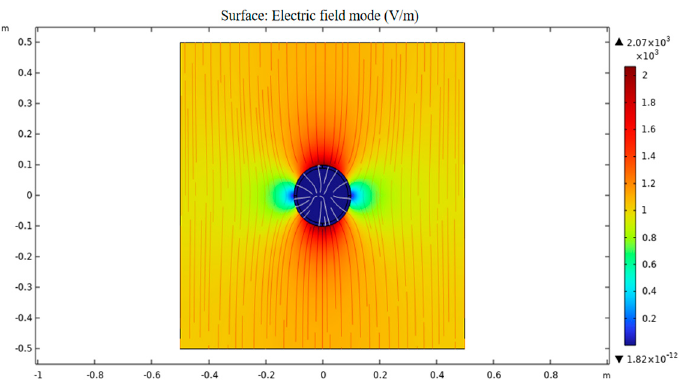
Figure 7. Electric field shielding simulation diagram.